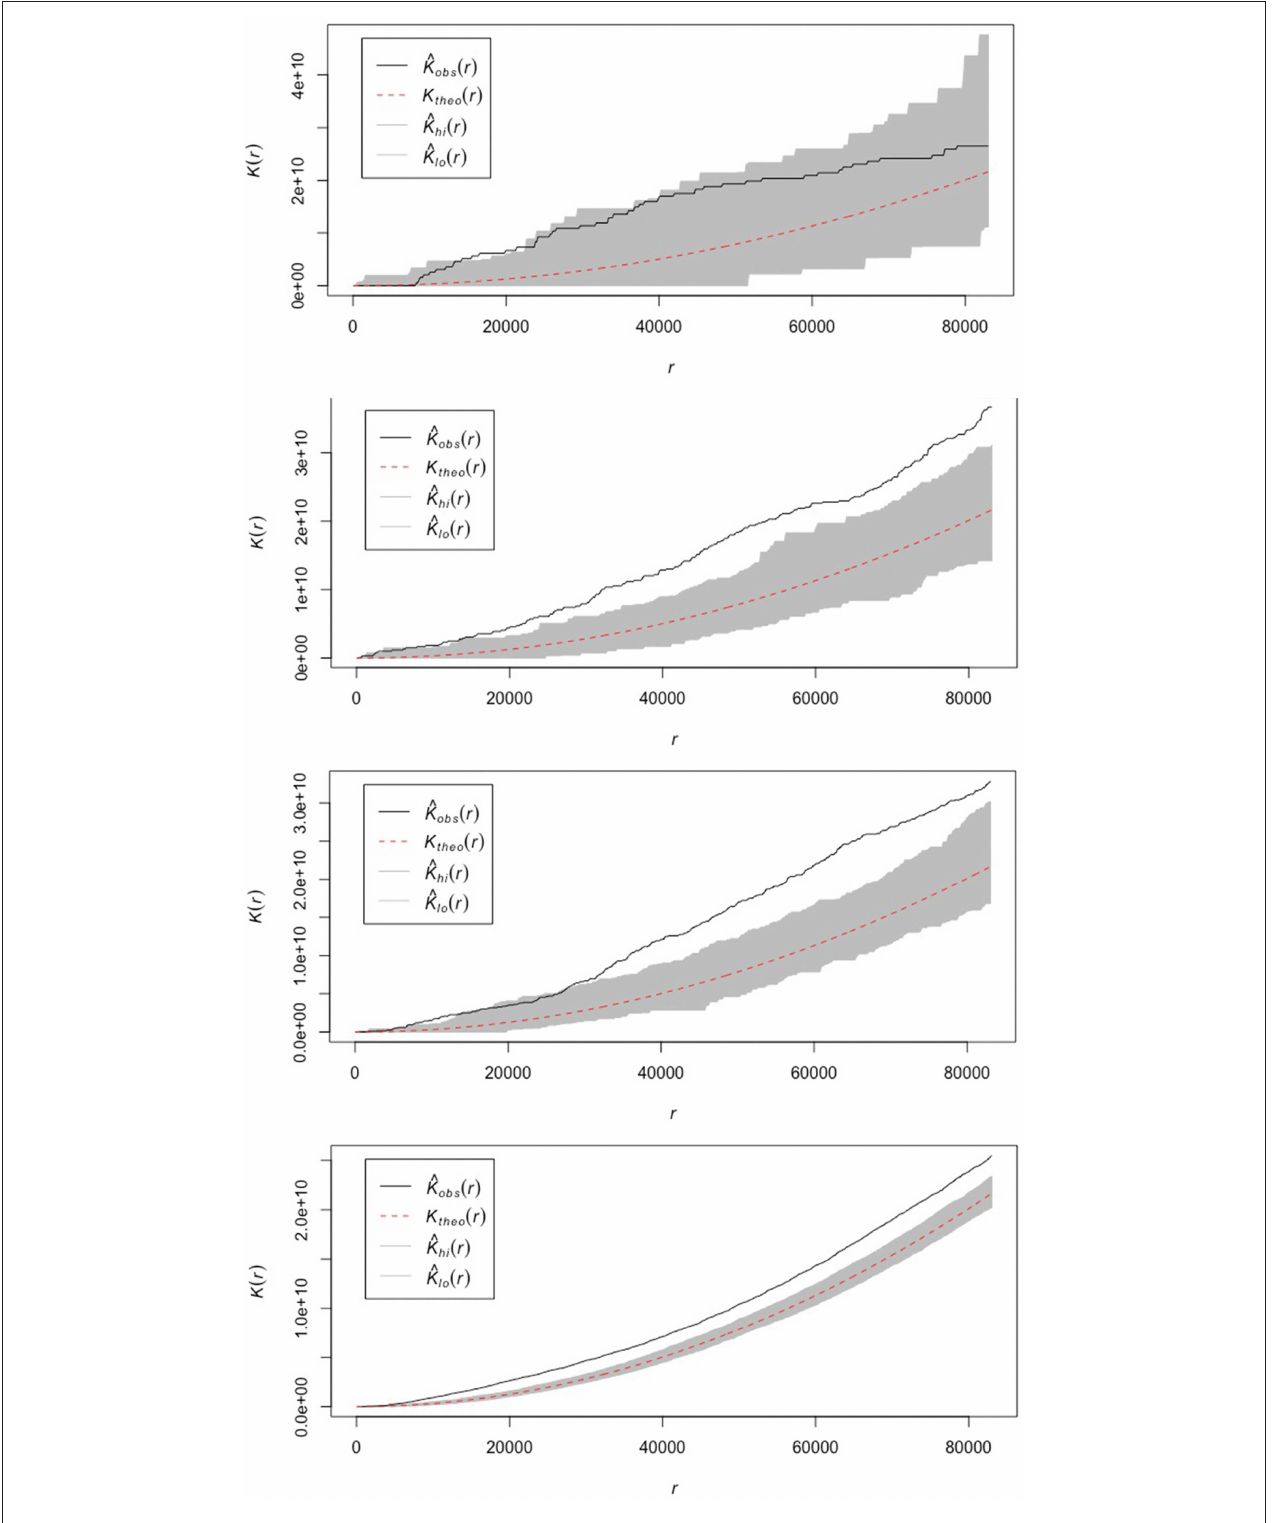
FIGURE 3 | Plots of the K-functions for (from Top to Bottom ) Forest Neolithic sites ( N = 27), Trypillia A sites ( N = 33), Trypillia BI sites ( N = 46), Trypillia BII sites ( N = 176). Distances r are in metres. The envelope has been generated from Monte Carlo simulation (999 iterations) under CSR.